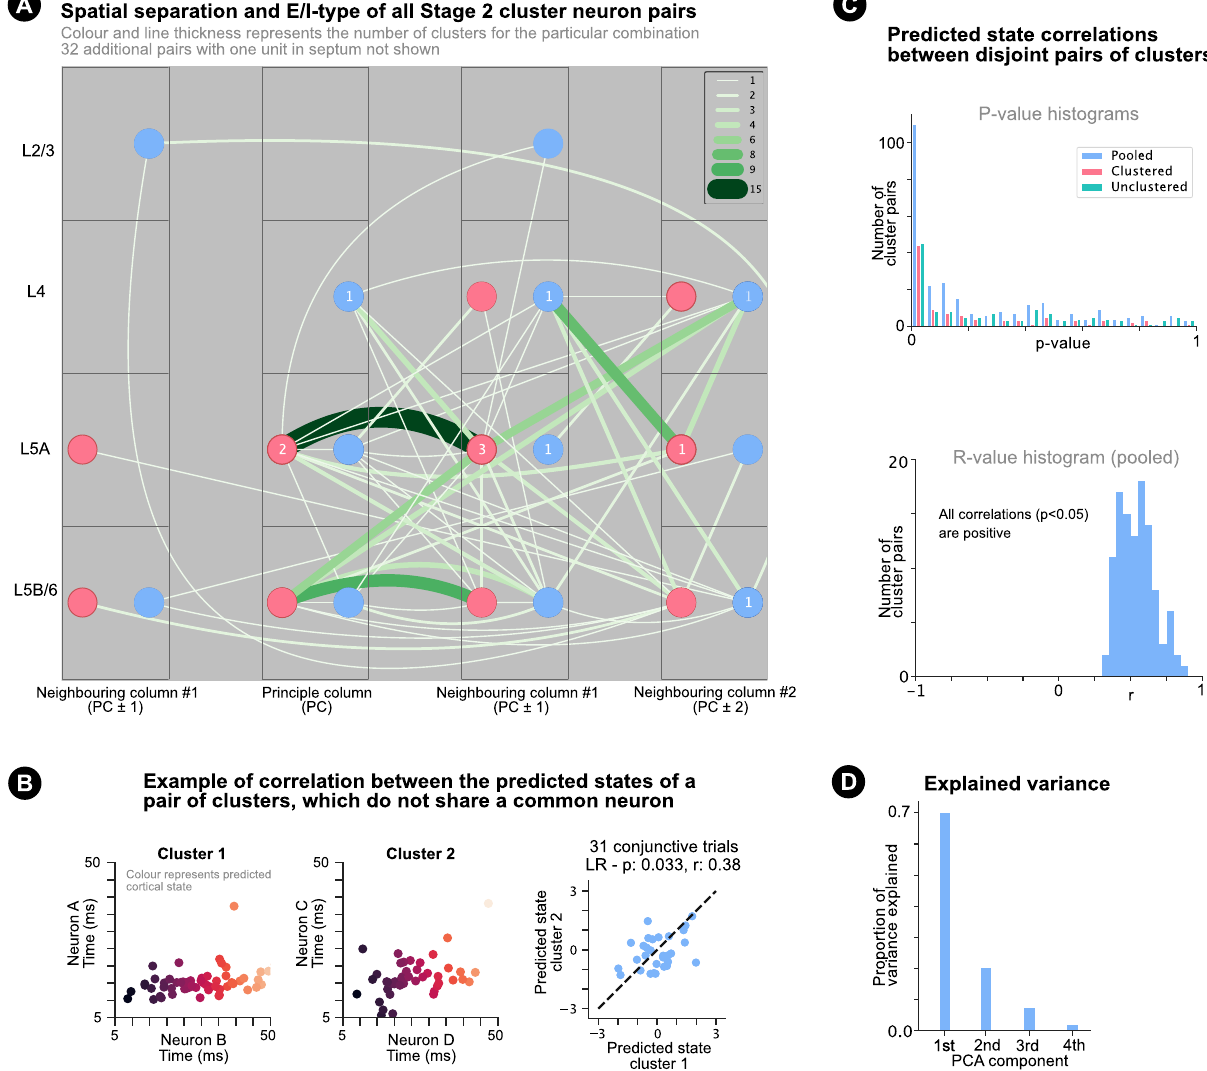
Figure 7. Neuron pair spatial separation and cortical state correlation. ( a ) Neuron pair spatial separation for criteria fulfilling correlated clusters (both stationary and ARIMA modelled). Line colour and thickness indicates the number of criteria fulfilling correlated clusters found for pairs of neurons in different layers and barrels and of different E/I-type. Red and blue correspond to E and I neuron types respectively. The numbers in the circles indicate the number of pairs of the same E/I type, layer and barrel. 32 neuron pairs were not added to the plot because at least one of the neurons in the pair lied in a septum (i.e. between barrels). ( b ) Example of two clusters which do not share a common neuron but have correlated cortical states over trials of a single stimulus. Left and centre: cluster spike times of two clusters coloured by predicted cortical state. Right: predicted cortical states for the two clusters are correlated on trials on which all 4 neurons spike. ( c ) Top: histograms showing p -values of linear correlation between predicted states of pairs of correlated pairs of neurons, which do not share a common neuron. Inclusion criteria: 15 conjunctive trials. Cases: clustered (redorange), unclustered (green) and clustered and unclustered pooled (blue). Bottom: r-value histograms of linear state correlations (clustered and unclustered pooled). ( d ) Mean variance explained by each PCA dimension between groups of 4 correlated neurons (on trials that all 4 neurons